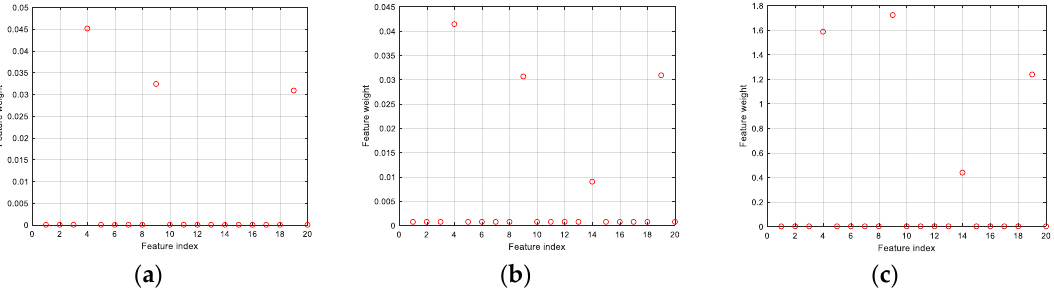
Figure 10. Extraction of principal component using neighborhood component analysis (NCA) for set A: ( a ) lbfgs; ( b ) Minibatch-lbfgs; ( c ) sgd.